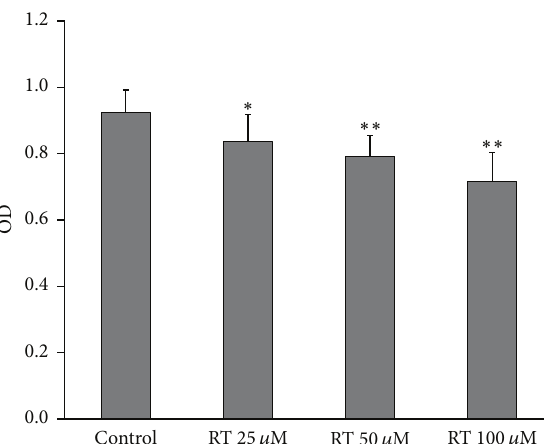
Figure 2: The effect of rutin on cell viability. Cells were treated with rutin (RT 25 𝜇 M, RT 50 𝜇 M, or RT 100 𝜇 M) for 24h. Data are shown as the means of three experiments. ∗ 𝑃 < 0.05 ; ∗∗ 𝑃 < 0.01 compared to